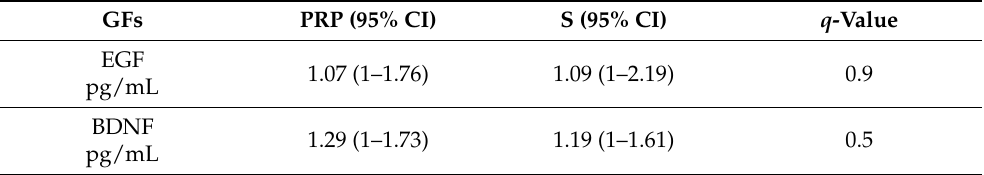
Table 3. Summary of the statistics extracted from the dataset. Each concentration was converted into a logarithmic (base 10) scale to standardize the concentration. We evaluated the geometric mean and 95% confidence intervals (mean ± std) of each concentration for each preparation, considering the two preparation types (fresh-frozen and fresh-dried) as paired variables. We compared the PRP and S groups using a two-sided t -test computing the associated p -value. These p -values were adjusted ( q -values) using the Benjamini–Hochberg correction for multiple tests.